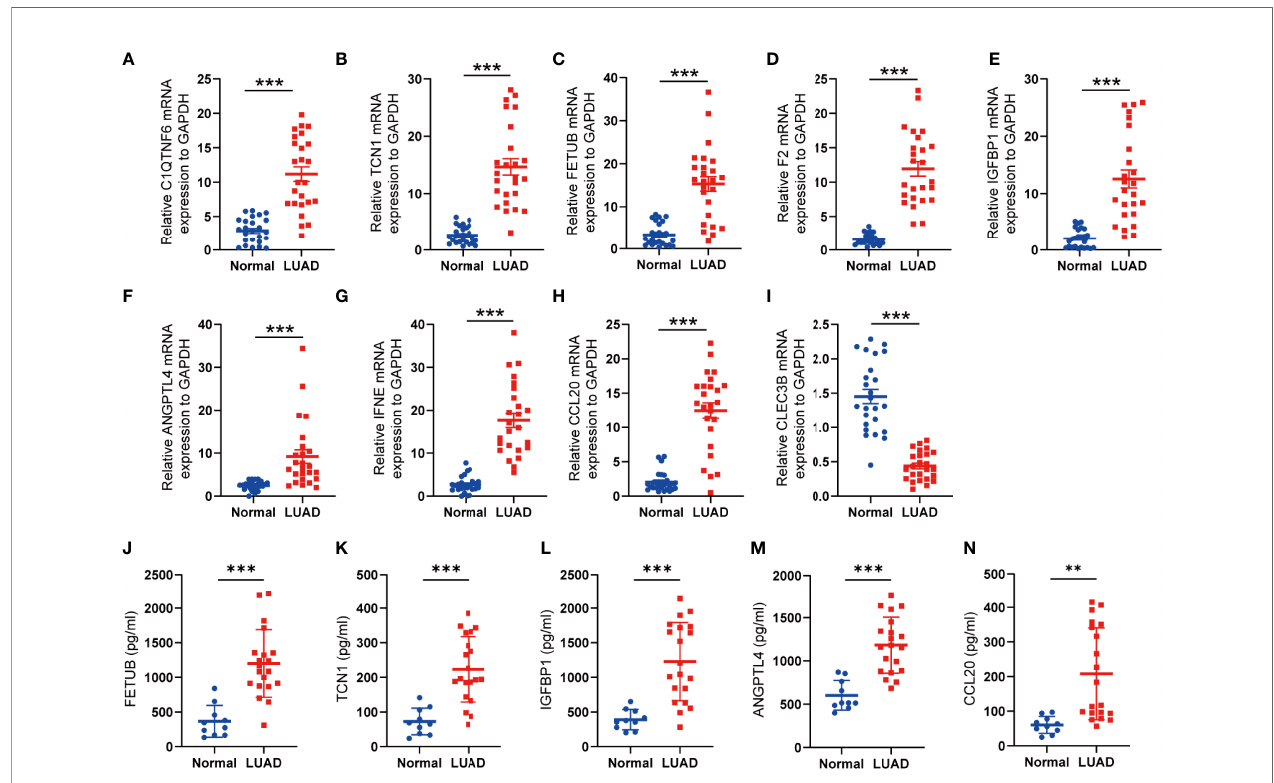
FIGURE 8 | Validation of the expression of SPRGs by qRT-PCR and ELISA. (A – I) Relative 9 SPRG mRNA expression between the normal and lung adenocarcinoma. (J – N) Plasma levels of the 5 secreted proteins between the normal and lung adenocarcinoma. ** P < 0.01, *** P < 0.001 by Student ’ s t -test.